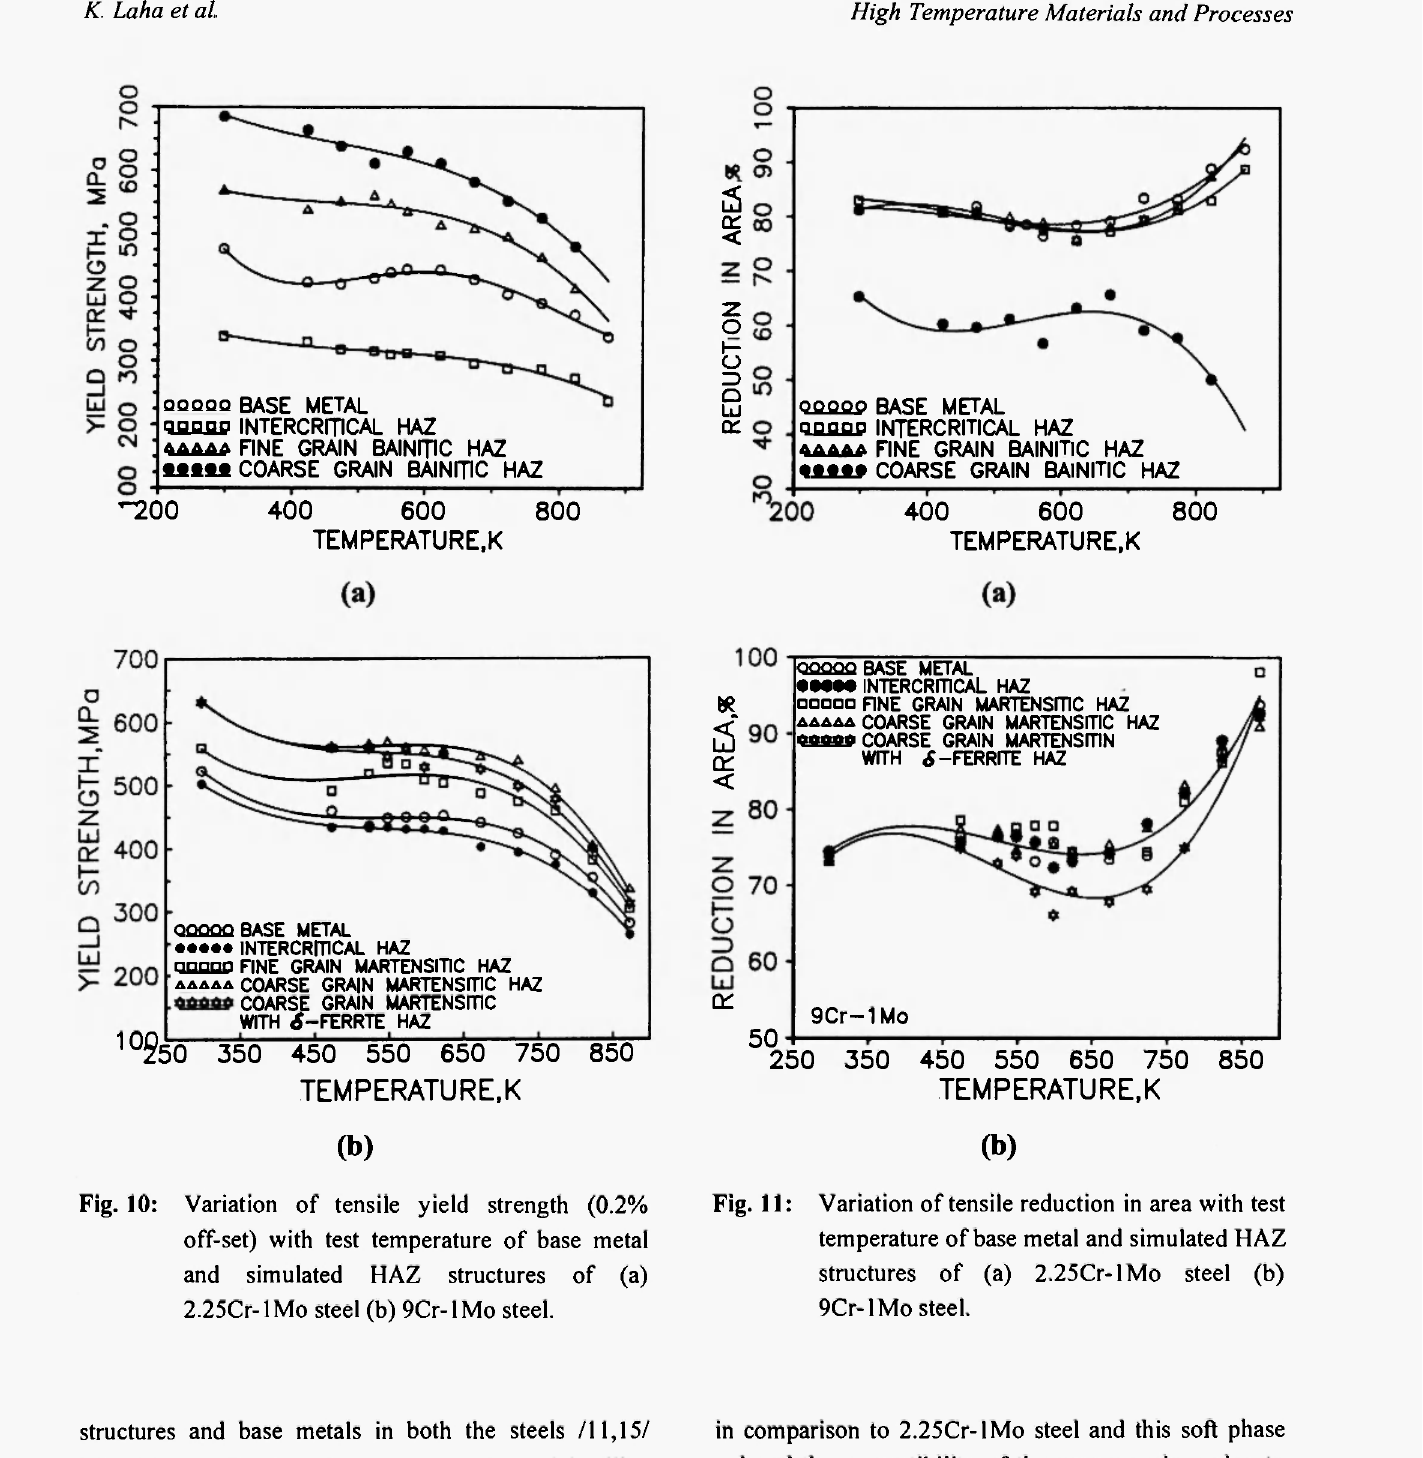
Fig. 10: Variation of tensile yield strength (0.2% off-set) with test temperature of base metal and simulated HAZ structures of 2.25Cr-lMo steel (b) 9Cr-lMo steel.